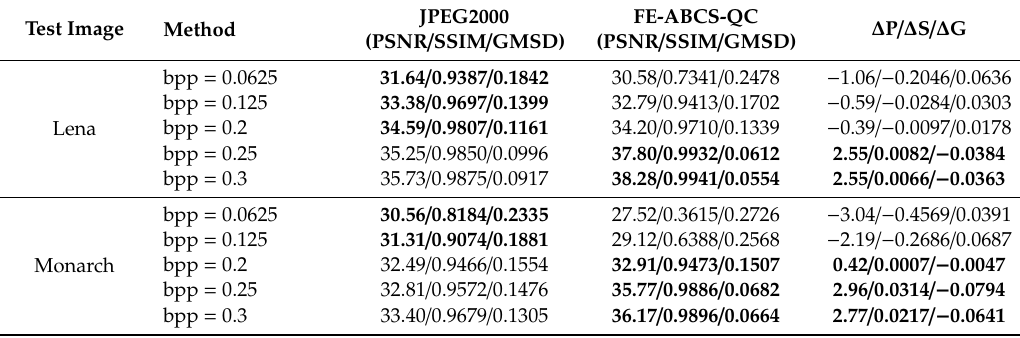
Table 5. The comparison results of di ff erent test-images under the various conditions (bits per pixel (bpp)) based on the JPEG2000 algorithm and the FE-ABCS-QC